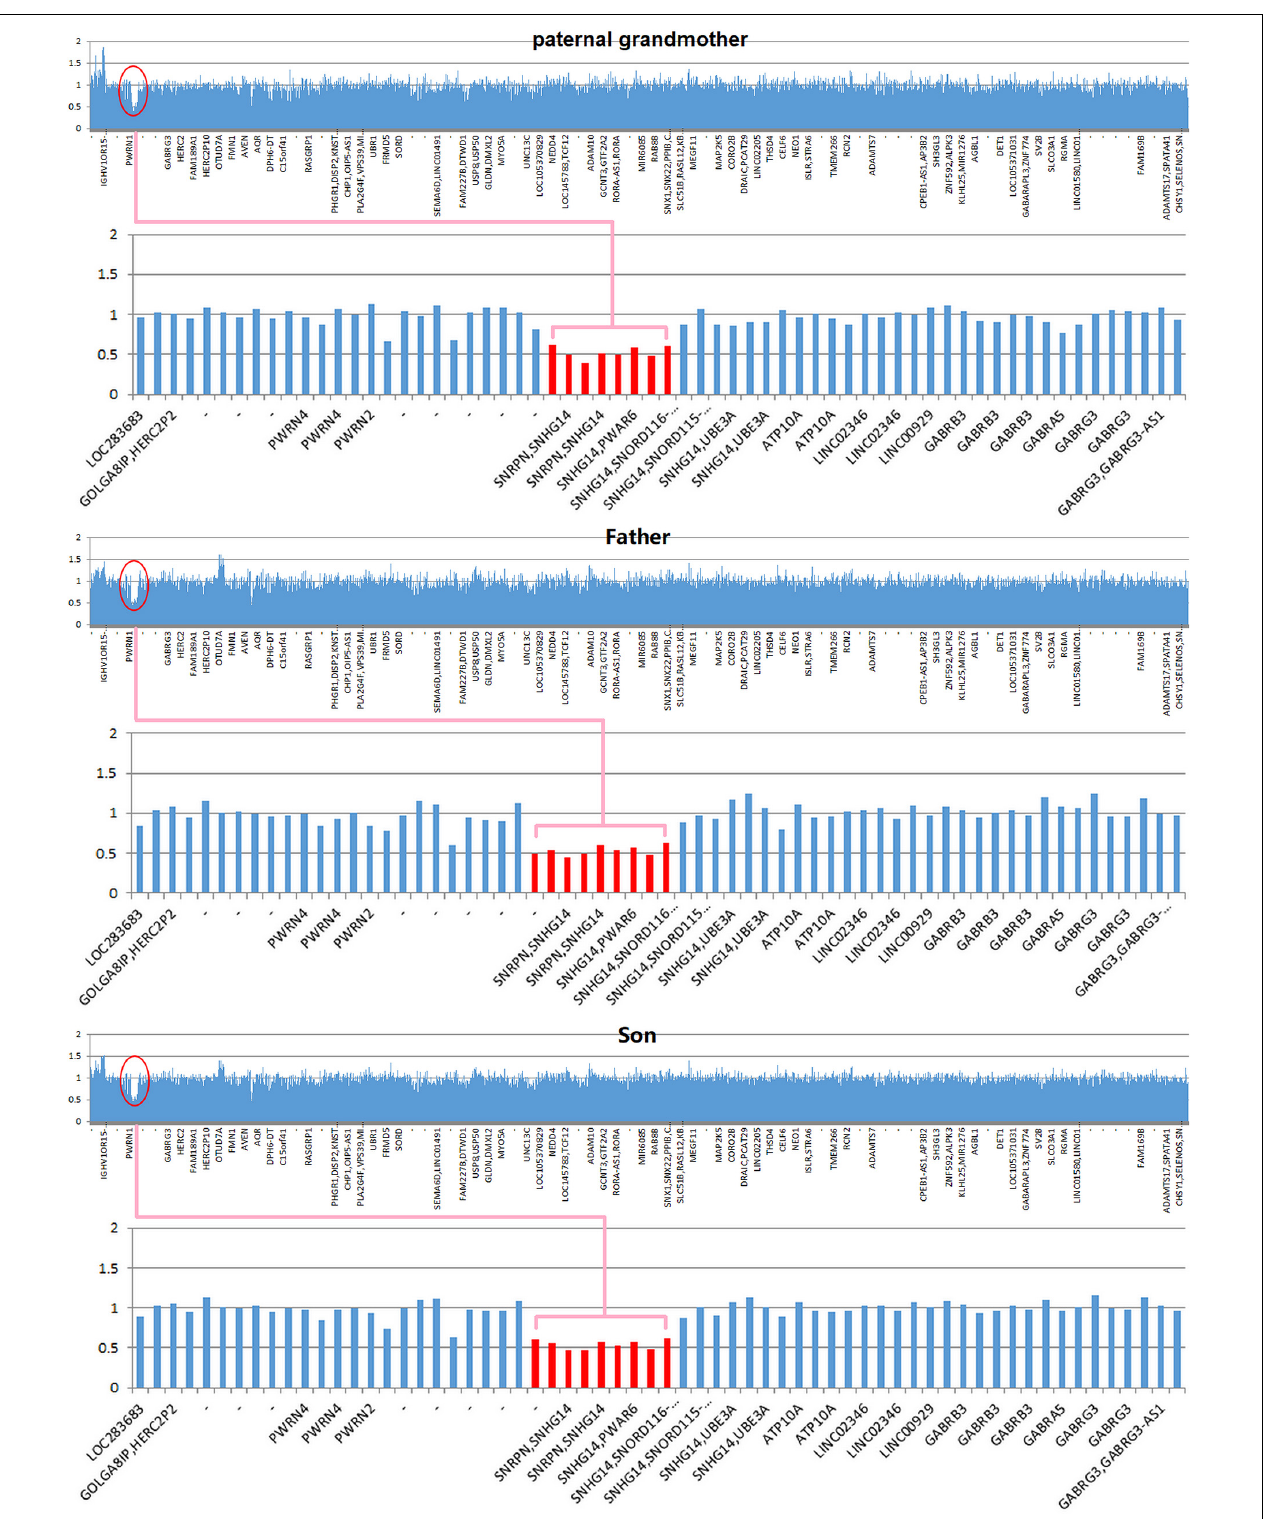
FIGURE 2 | Copy number variation (CNV) sequencing reveals a de novo 500-kb heterozygous deletion of 15q11.2 (chr15: 24,932,524–25,482,598) in the paternal grandmother, the father, and the patient. The deletion encompasses five Online Mendelian Inheritance in Man (OMIM) genes including SNRPN , SNHG14 , PWAR6 , SNORD115 , and SNORD116 (highlighted in pink box).